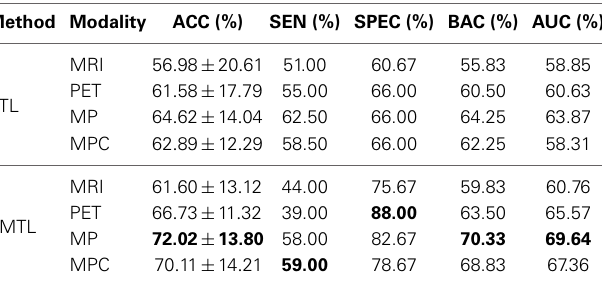
Table 6 | A summary of the performances for MCI-C vs. MCI-NC classification.